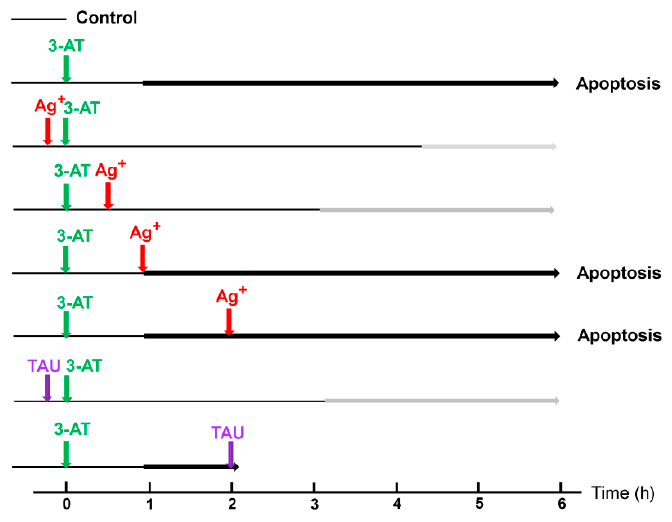
Figure 4. Aquaporin-mediated effects are restricted to the early phase of apoptosis induction. 12,500 MKN-45 gastric carcinoma cells were seeded in 96 well plates (100 µL medium). ( A ): Assays remained without 3-AT or received 100 mM 3-AT, where indicated. Ag+ was added were indicated, either 10 min before 3-AT or 30, 60 or 120 min after 3-AT. ( B ): Assays remained with 3-AT or received 100 mM 3-AT. Where indicated, the HOCl scavenger taurine was added either 10 min before or 120 min after 3-AT addition. The percentages of apoptotic cells were determined kinetically. The experiment shows that inhibition of catalase causes apoptosis induction with a lag phase of about one hour. Inhibition of aquaporins starting before the addition of 3-AT caused complete inhibition of apoptosis induction. Inhibition of aquaporins 30 min after 3-AT addition was slightly less effective and addition of the aquaporin inhibitor at 60 min caused almost no more inhibition. In contrast, addition of the HOCl scavenger taurine caused strong inhibition after addition before 3-AT or 120 min after its addition. These data show that apoptosis induction requires inhibition of catalase and the action of aquaporins during the first 60 min, i.e., during the lag phase of apoptosis induction, whereas HOCl signaling is required during the complete process of apoptosis induction.